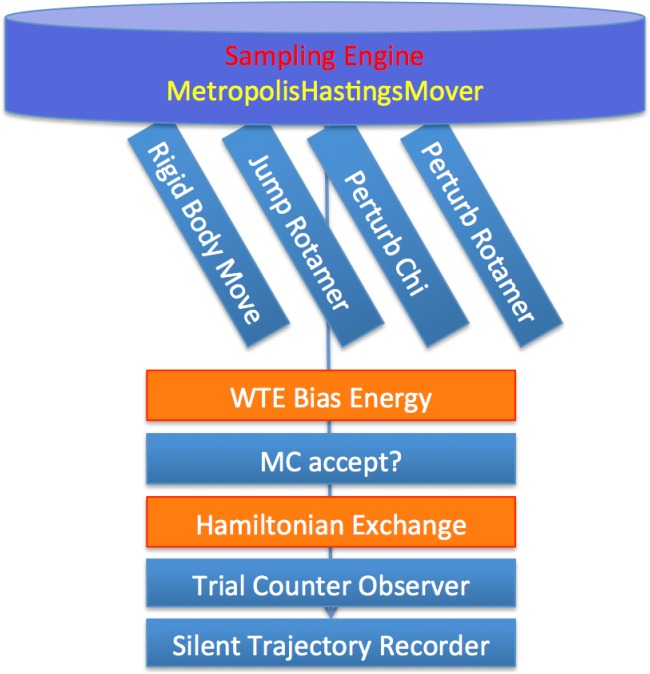
Workflow represented by combination of Rosetta modules and setup of the four docking protocols.The modules in orange, representing the enhanced sampling techniques of replica exchange and well-tempered ensemble, are only applied in the combined protocols.